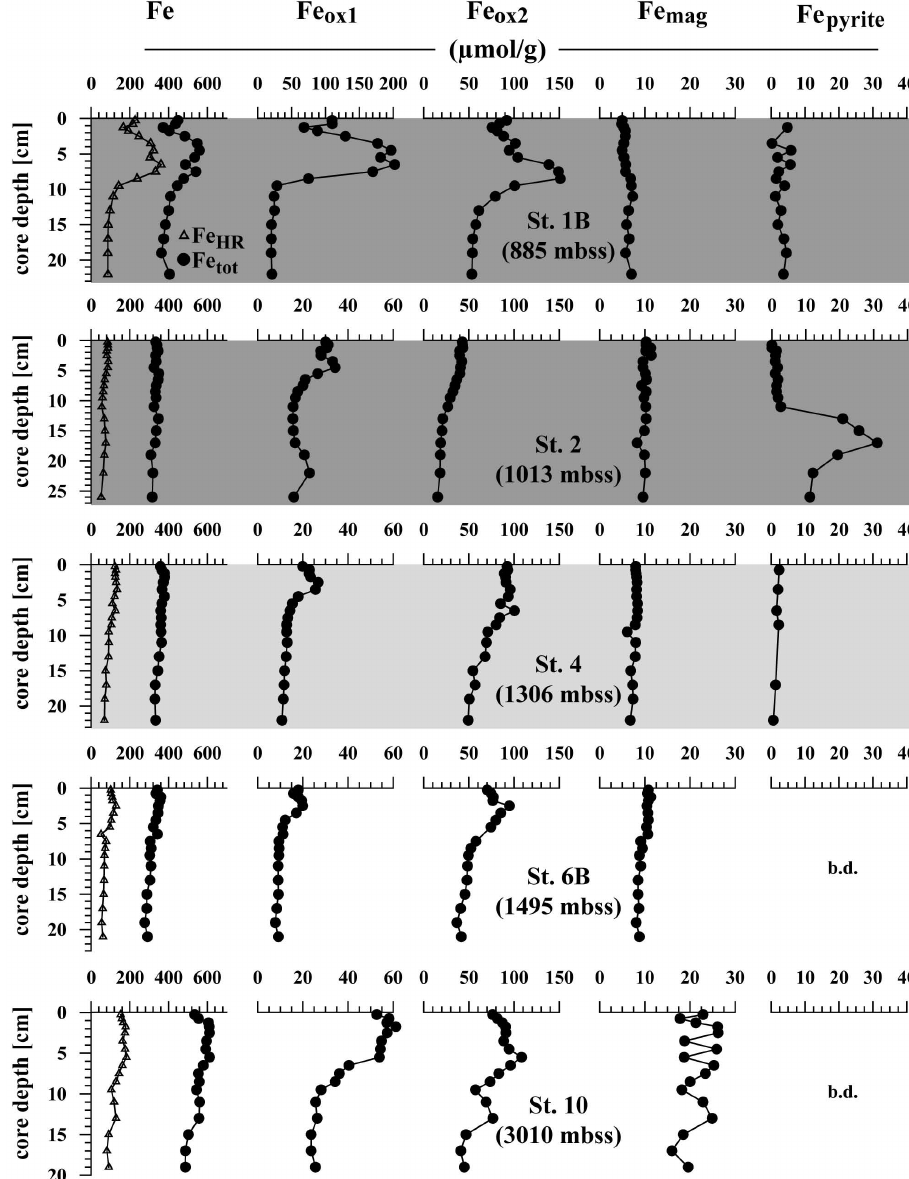
Fig. 6. Iron speciation in the cores from stations 1B, 2, 4, 6B and 10 determined by sequential extraction: total Fe (Fe tot ) , highly reactive Fe (Fe HR ) calculated as the sum of all non-detrital Fe phases: poorly crystalline Fe (oxyhydr)oxides (Fe ox1 ) , crystalline Fe (oxyhydr)oxides (Fe ox2 ) , recalcitrant Fe oxides (mainly magnetite, Fe mag ) , and Fe in pyrite (Fe pyrite ) . b.d. = below the detection limit. Carbonate-associated Fe was negligible in all cores and is therefore not shown. Fill colours indicate station position as detailed in the caption to Fig.